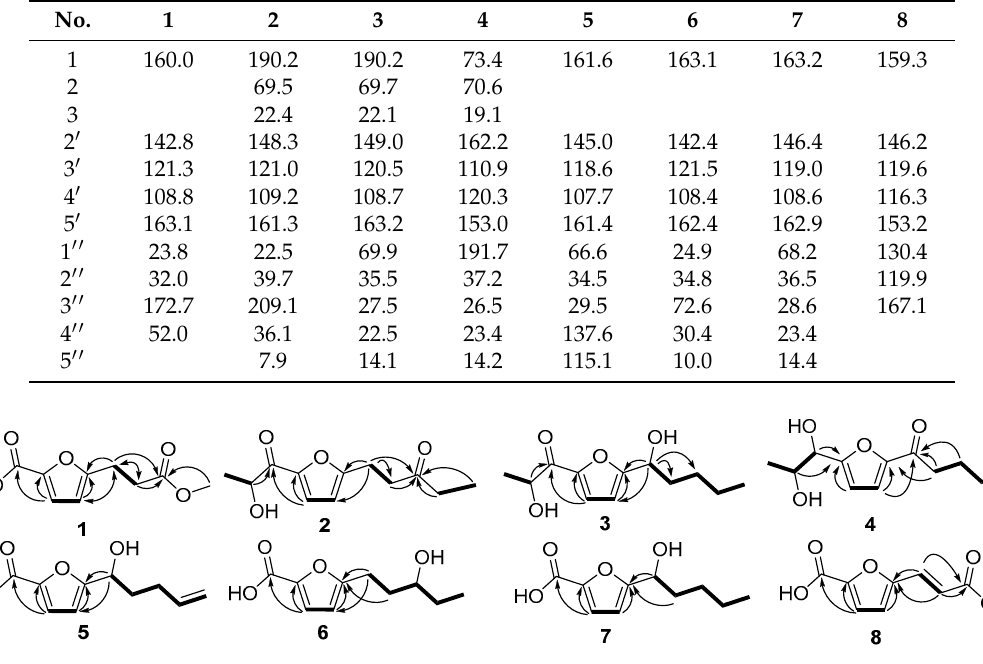
Figure 2. Key 1 H- 1 H COSY (bold lines) and HMBC (arrows) correlations of compounds 1 – 8 .